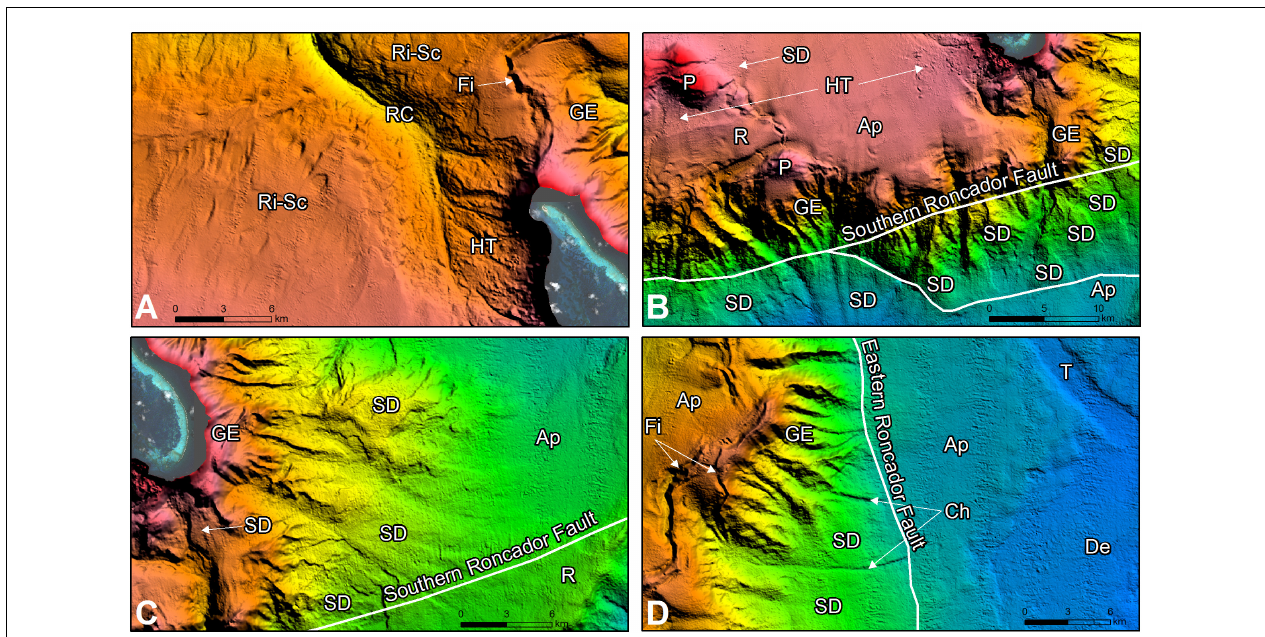
FIGURE 6 | Detail of some of the most important geoforms associated with Roncador Bank. (A) Northwestern sector of Roncador where a hummocky terrain (HT) is identified in the proximal reach of the Roncador Canyon (RC). (B) Southern escarpment of Roncador where a series of gullies and slope deposits (SD) are present. This escarpment is controlled by the Southern Roncador Fault. At the top of the escarpment, there are two pinnacles (P). (C) Gullied escarpment (GE) in the southeastern sector of Roncador, and extensive slope deposits (SD) at the foothills. (D) Eastern escarpment of Roncador which is controlled by the Eastern Roncador Fault. At the top of the escarpment, a fissure (Fi) is identified. The satellite image covers the reef constructions shallower than –40 m and the permanently emerged areas (cays). Ri-SC, terrain with minor ridges and scarps corresponding to large-scale landslides deposits; R, ridge; Ap, archipelagic apron; De, depression; T, trough; Ch, channel. See Figure 4 for